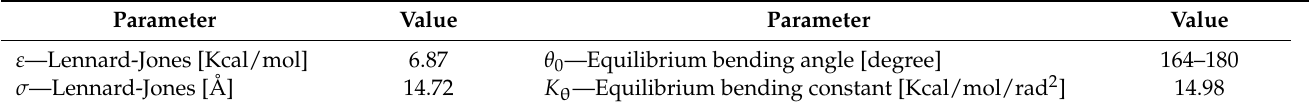
Table 3. Pairwise and angle-energy